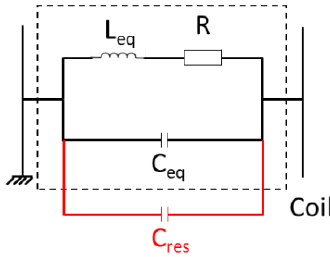
Figure 8. Equivalent model of a coil with the addition of a capacitor in order to operate at the resonance frequency.